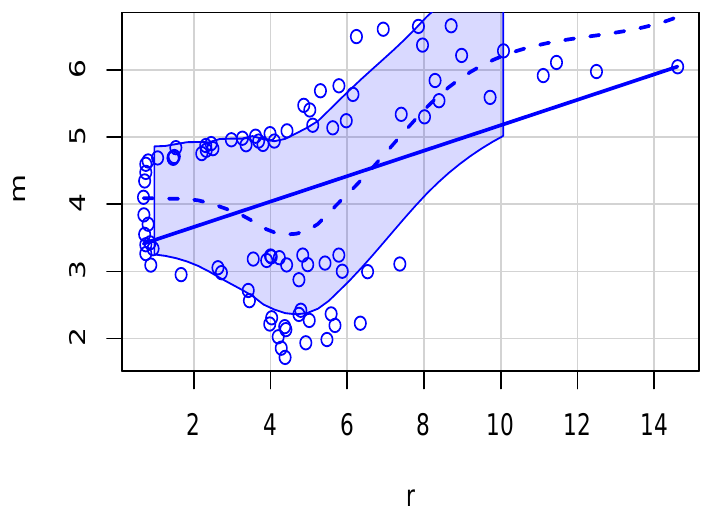
Figure 2. Macro example scatterplot of m and r illustrating